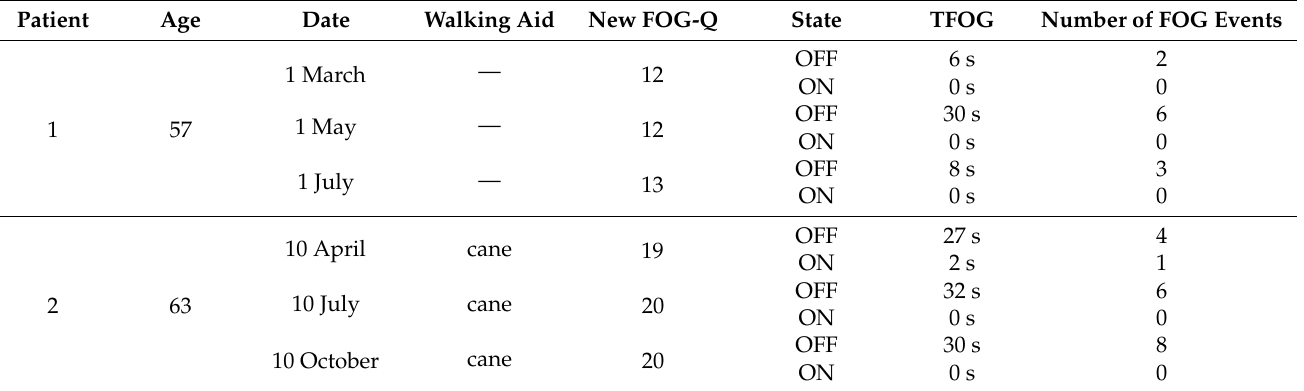
Table 8. An example of how the proposed physical mobility motor task can be used to record changes in the duration and number of FOG events over